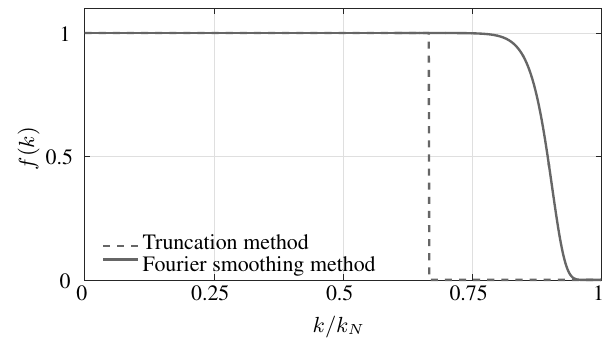
Figure 1. Weighting functions used in the FT method (dashed line) and the FS method (continuous line). The FT method filters scales with k/k N > 2 / 3 and the FS method at k/k N > 3 /